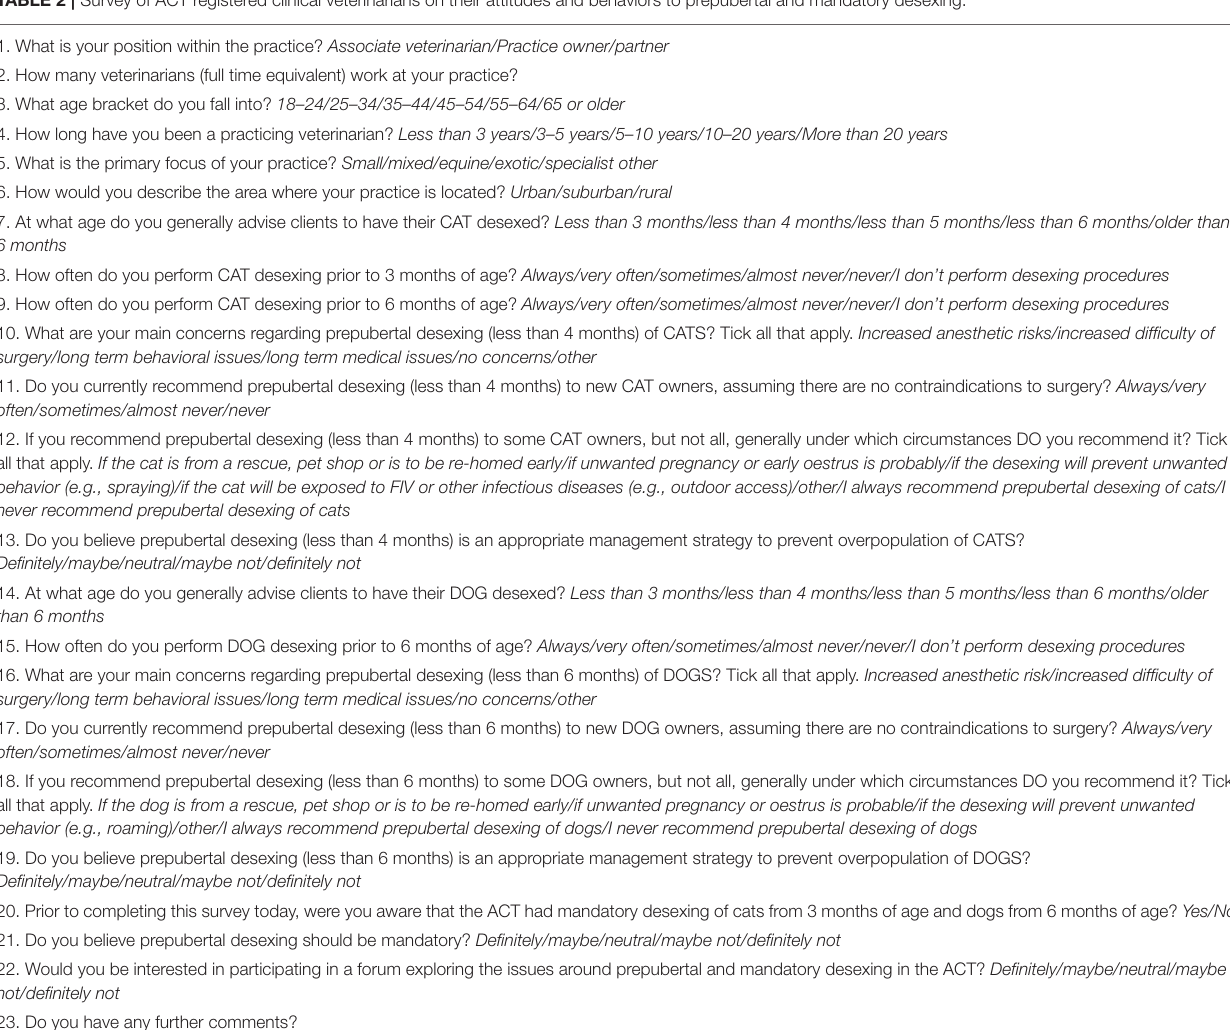
TABLE 2 | Survey of ACT registered clinical veterinarians on their attitudes and behaviors to prepubertal and mandatory